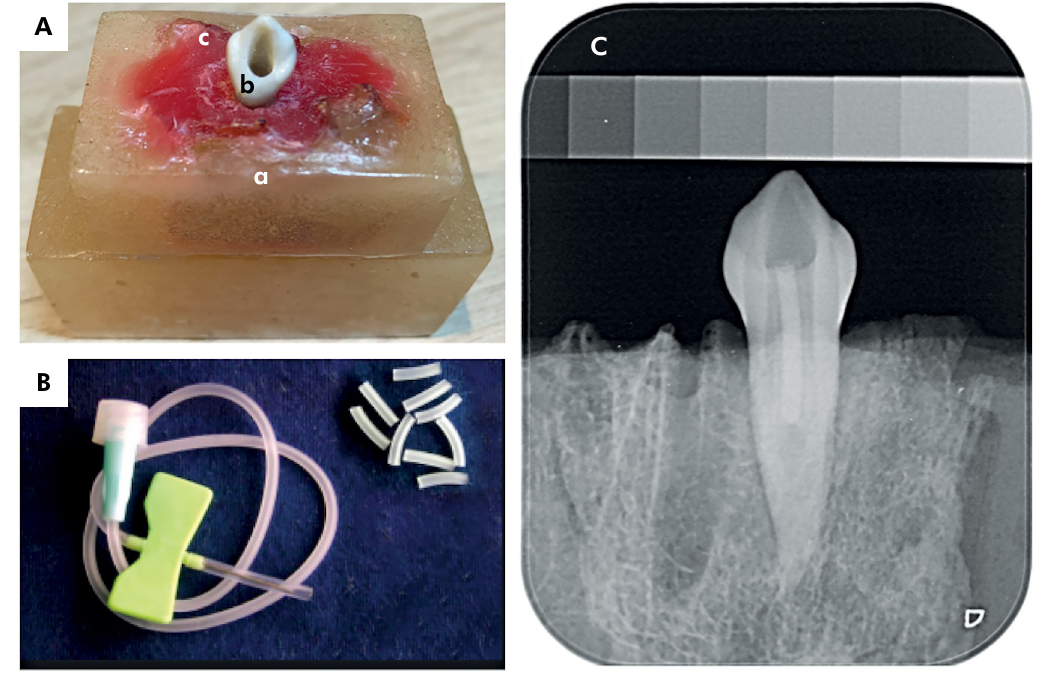
Figure. (A) Tissue simulator. Acrylic block simulating soft tissues and containing a fragment of osseous tissue (a) and a canine tooth (b) involved by utility wax to simulate periodontal ligament (c). (B) Polyethylene tubes into which the bioceramic cements were inserted. (C) Radiographic image of a polyethylene tube filled with Biodentine and inserted into a canine tooth in the tissue simulator, in addition to an aluminum